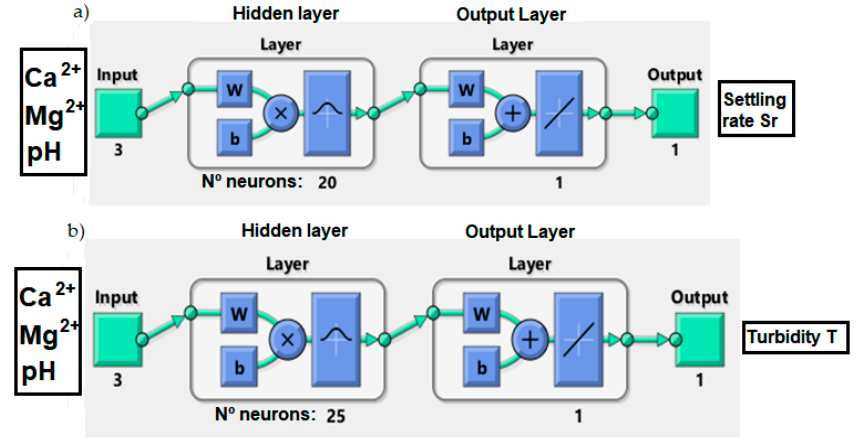
Figure 7. MATLAB structure for the RBFN ( a ) settling rate and ( b ) turbidity. Table 5. Settling rate and turbidity weights (w) and bias (b) values from processing data by MATLAB. Settling Rate Sr Turbidity